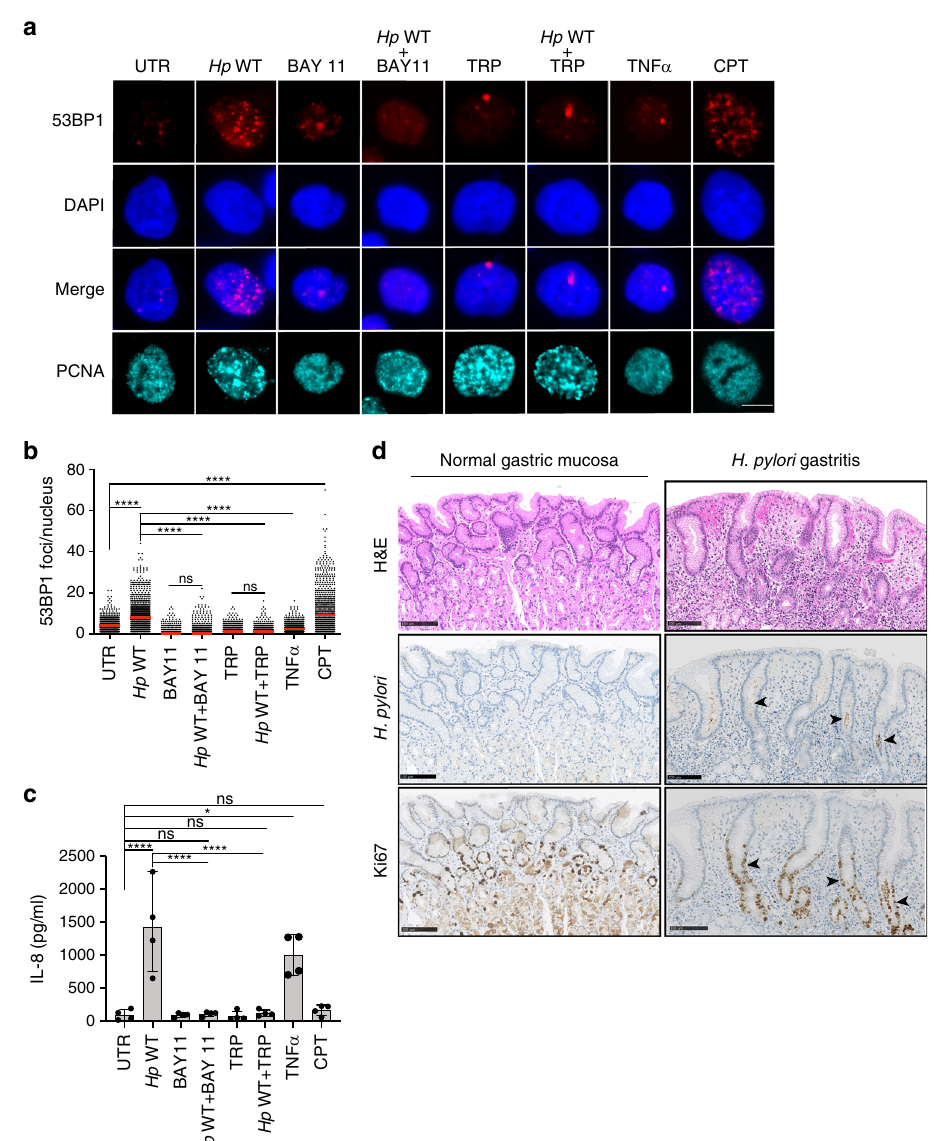
Fig. 2 H. pylori -induced DNA DSBs require active transcription and NF- κ B activation. a – c Wild-type AGS cells were infected for 6 h with H. pylori P12 at an MOI of 50 in the presence or absence of the NF- κ B inhibitor BAY 11-7082 and the transcription inhibitor triptolide (1 μ M and 100 nM fi nal concentration, respectively), or treated with 10 nM TNF- α or 100 nM camptothecin (CPT) for 6 h, and subjected to immuno fl uorescence staining for 53BP1 and PCNA. Representative images are shown in a (scale bar, 10 μ m) alongside scatter dot plots of >430 and up to 954 cells per condition in b . IL-8 secretion as assessed by ELISA is shown in c . Data in b and c are pooled from four independent experiments. Red lines indicate medians. Data in c are represented as mean + SEM of three independent experiments. P -values were calculated by one-way ANOVA with Dunn ’ s multiple comparisons correction in b and by two-way ANOVA with Tukey ’ s multiple comparisons correction in c . ns, not signi fi cant; * p < 0.05, ** * * p < 0.0001. d Immunohistochemical analysis of H. pylori staining relative to Ki67 + cells in the gastric mucosa of patients presenting with (right panels) or without gastritis (left panels); six patients with gastritis and three control patients were stained with very similar results. Hematoxylin and eosin (H&E)-stained sections are shown as well. Scale bars, 100 μ m. Arrows point to areas where H. pylori resides in close proximity to proliferating